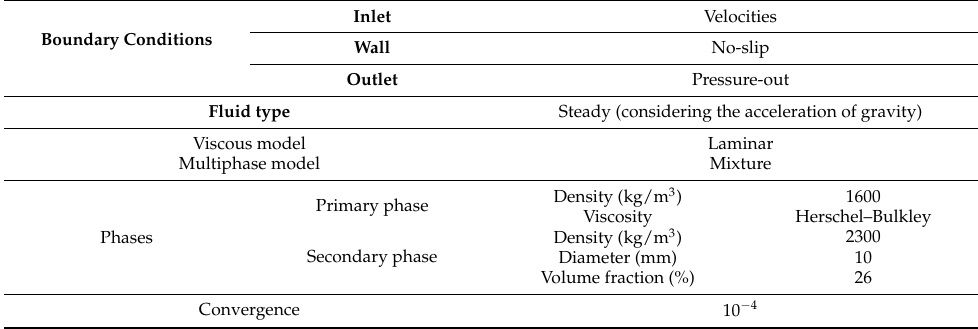
Table 1. Boundary conditions and parameters setting.